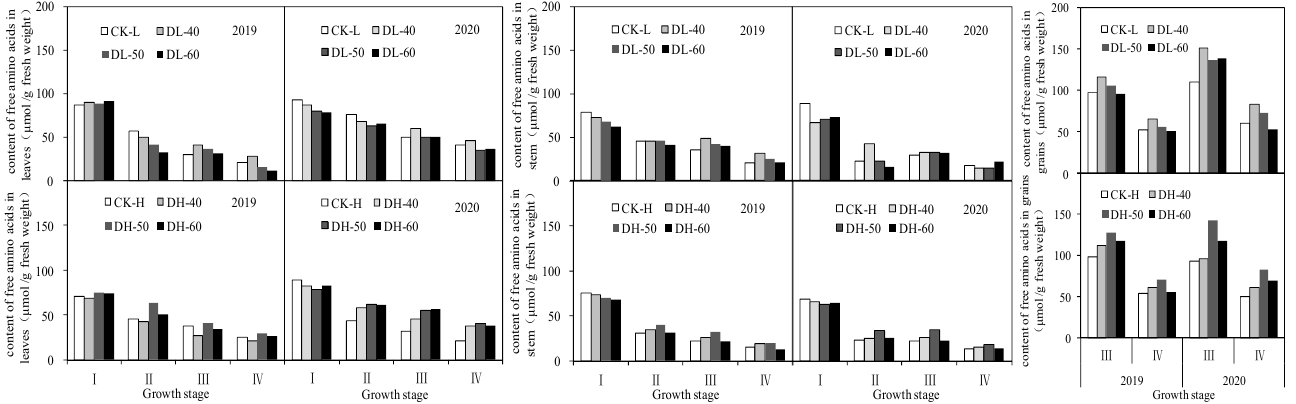
Figure 3. Effects of density and fertilization on AA content in organs of forage maize.